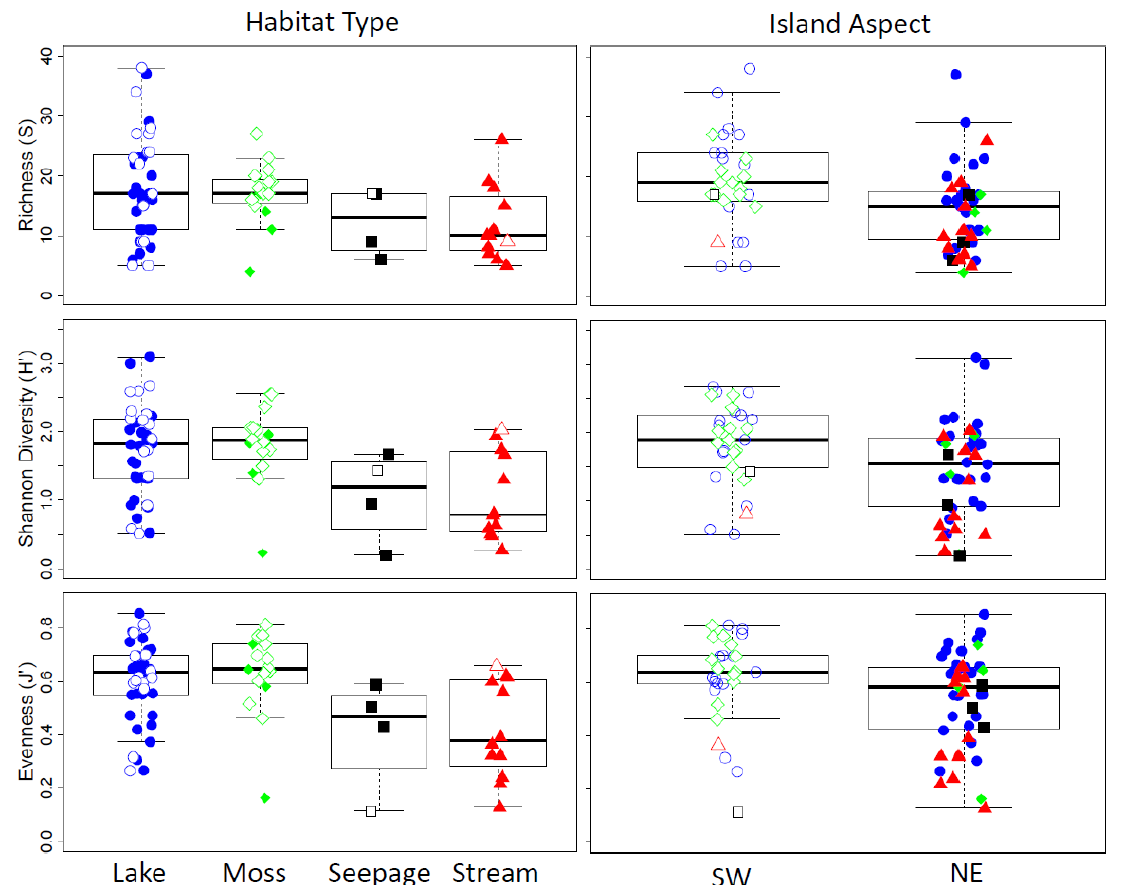
Figure 5. Boxplots of species richness (S), Shannon diversity (H’), and evenness (J’) calculated by habitat type (left column) and island aspect (right column). Pond habitats are indicated by blue circles, moss habitats by green diamonds, seepages by black squares, and streams by red triangles. Symbols for Devil’s Bay are filled, and Cape Lamb sites are represented by outlines only. Box bottoms and tops represent first and third quartiles, and thick black lines represent median values.